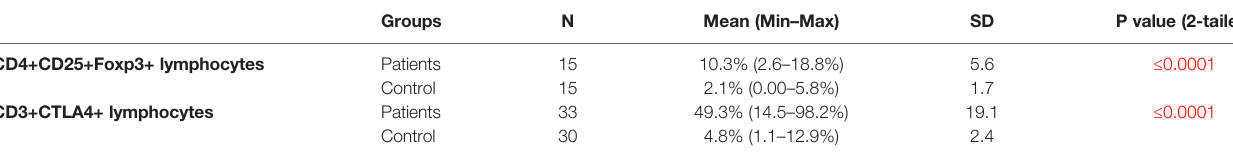
TABLE 4 | Flow cytometry results of Treg and CD3/CTLA4 in patients and